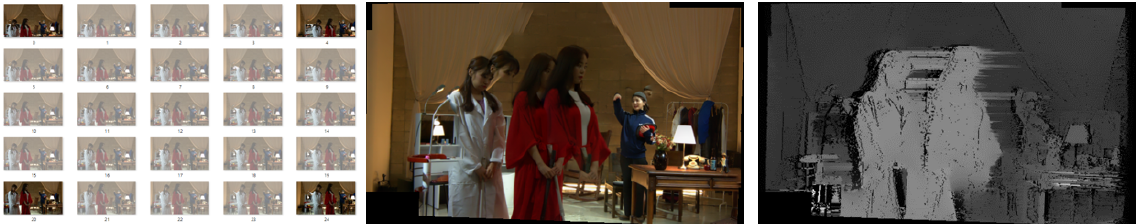
Figure 15. The results of the synthesized images is improved with accurate homography estimation in addition to accurate detection of the overlapped regions. ( a ) Synthesis before homography optimization. ( b ) Synthesis with homography optimization.